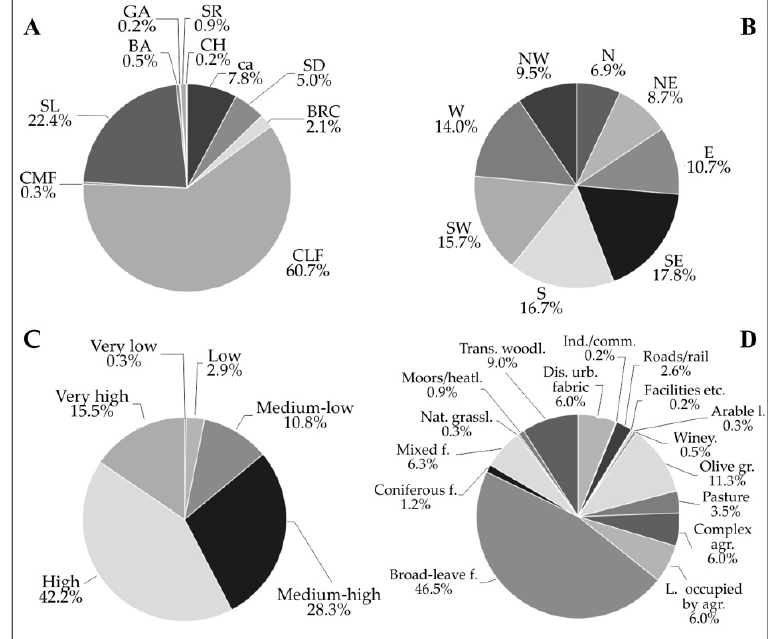
Figure 9. Statistical distribution of predisposing factors in areas affected by landslides in the Entella River basin: ( A ), lithology; ( B ), slope aspect; ( C ), slope steepness; ( D ), River basin: ( A) , lithology; ( B ), slope aspect; ( C ), slope steepness; ( D ), land-use.